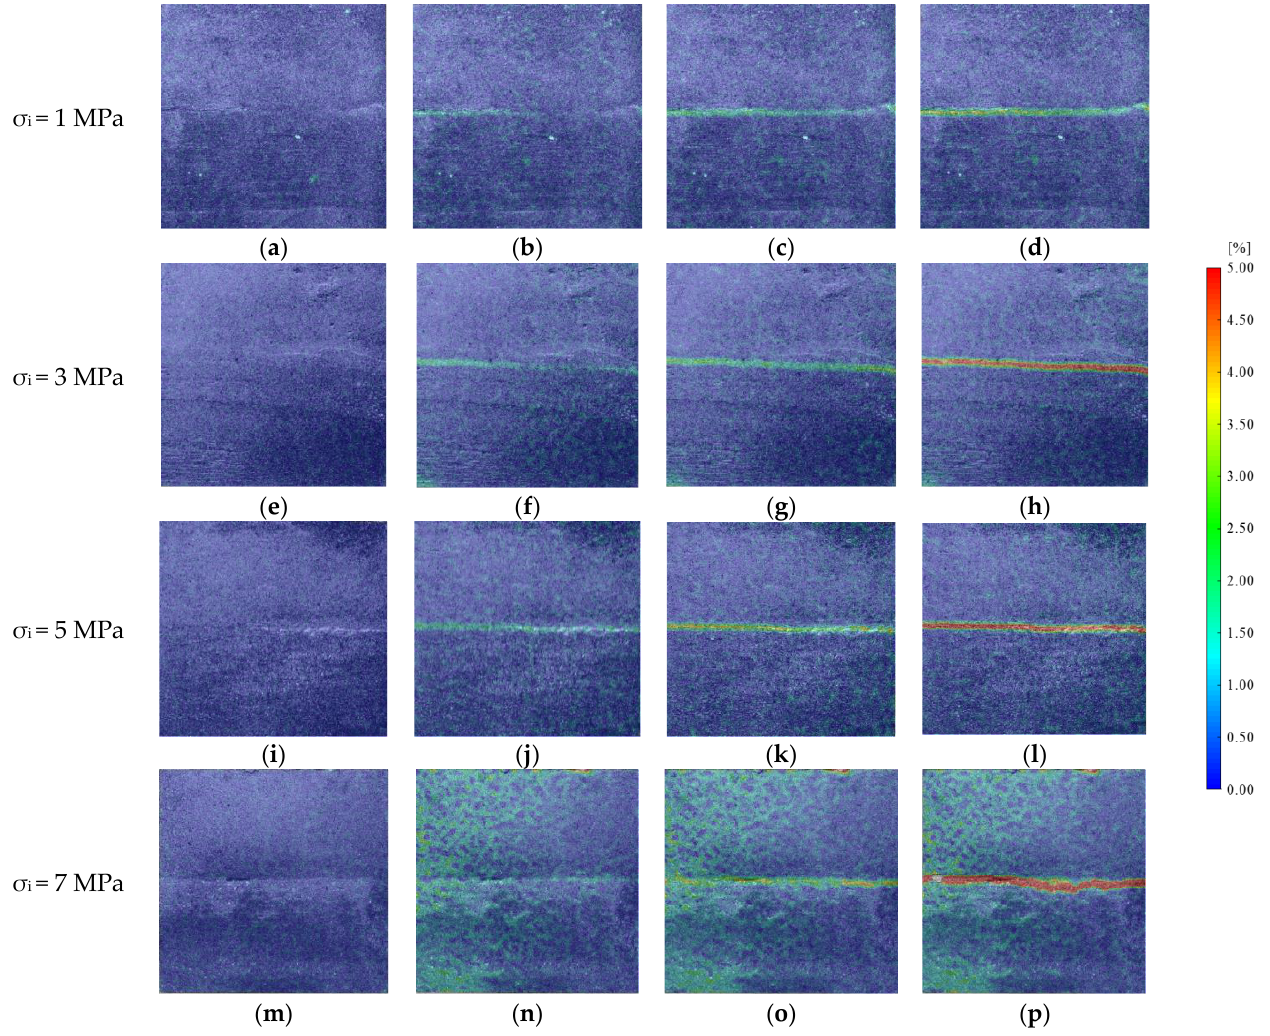
Figure 6. Principal strain field of specimens at different initial normal stress. ( a ) Frame 0. ( b ) Frame 480. ( c ) Frame 963. ( d ) Frame 1442. ( e ) Frame 0. ( f ) Frame 725. ( g ) Frame 1398. ( h ) Frame 2736. ( i ) Frame 0. ( j ) Frame 1046. ( k ) Frame 3329. ( l ) Frame 4792. ( m ) Frame 0. ( n ) Frame 1652. ( o ) Frame